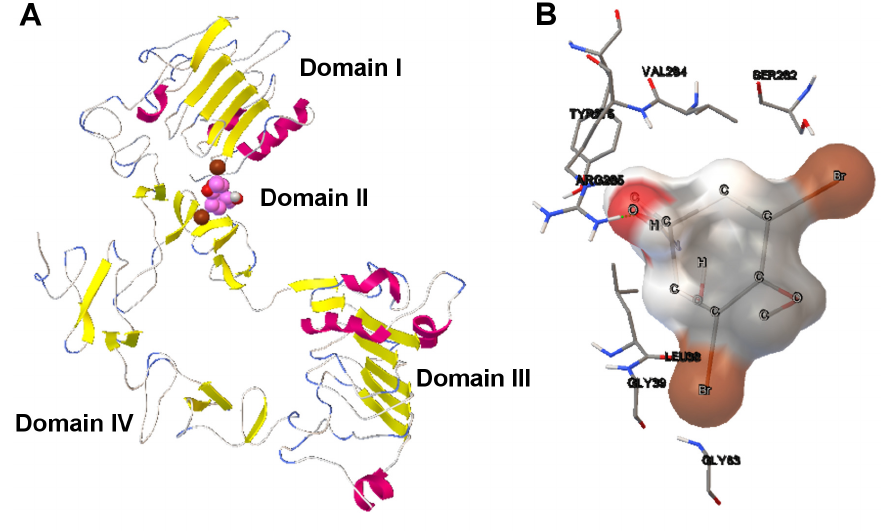
Figure 11. ( A ) The tridimensional structure of EGFR receptor with the four domains labeled; ( B ) The molecular interaction between aeroplysinin-1 and the EGFR receptor. The H-bond is represented by green spheres. The amino acids of the binding site and the ligand atoms have been also